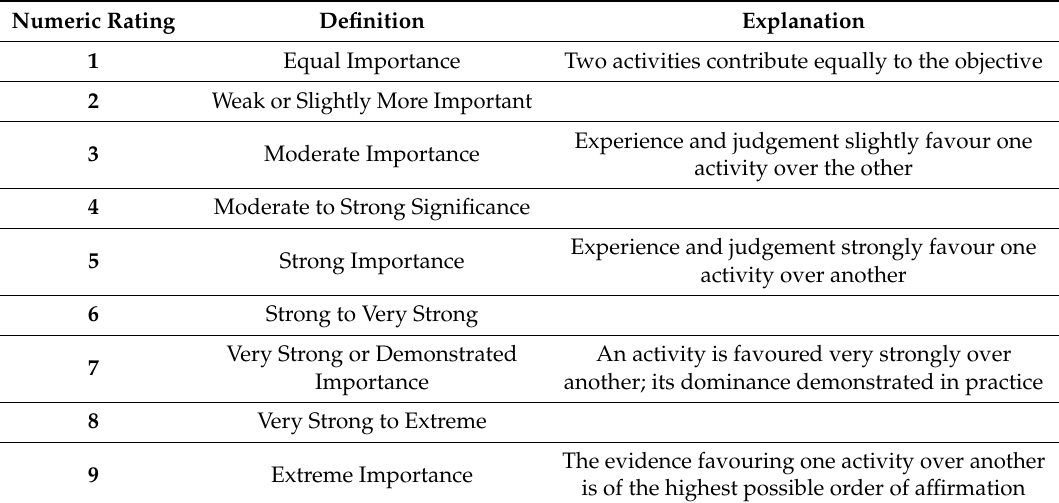
Table 3. The scale proposed by Saaty